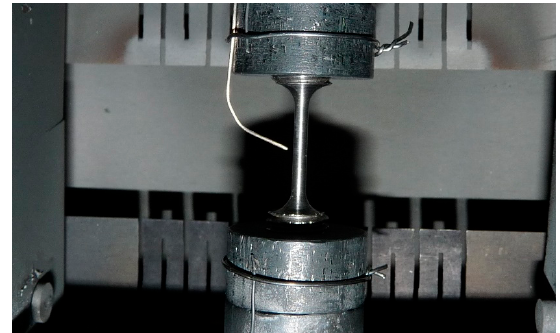
Figure 2. Position of the three thermocouples.